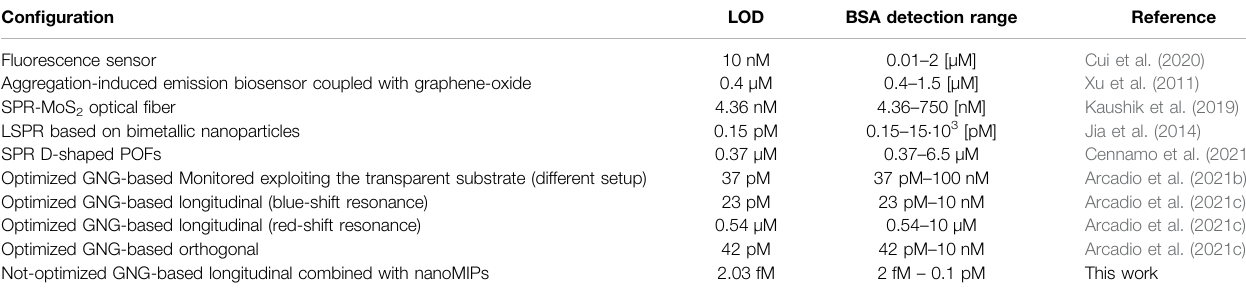
TABLE 3 | Characteristics of several sensors ’ con fi gurations for the selective detection of BSA. Con fi